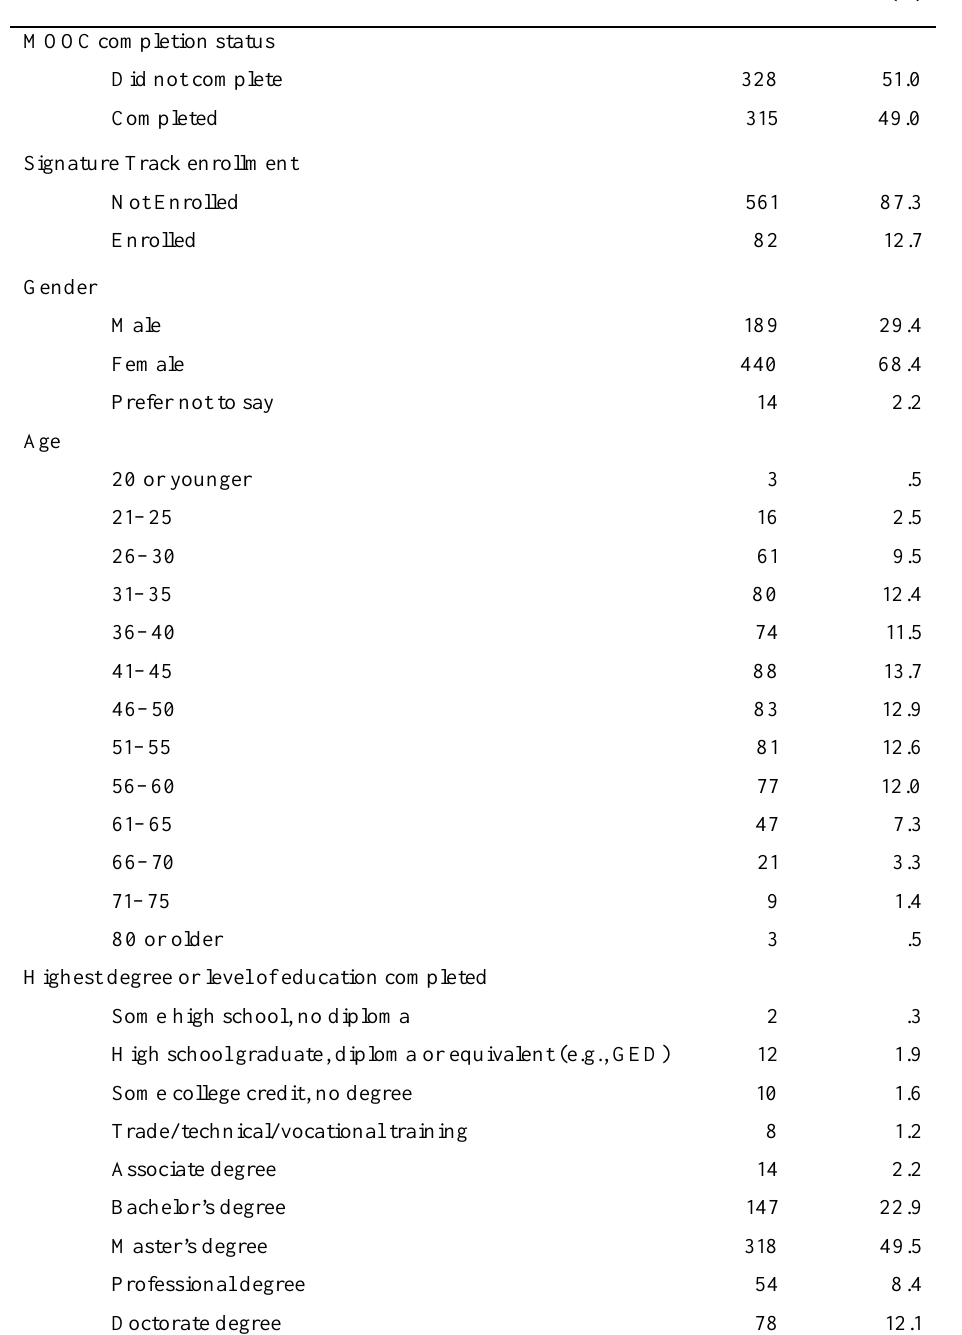
Respondents’ Demographic